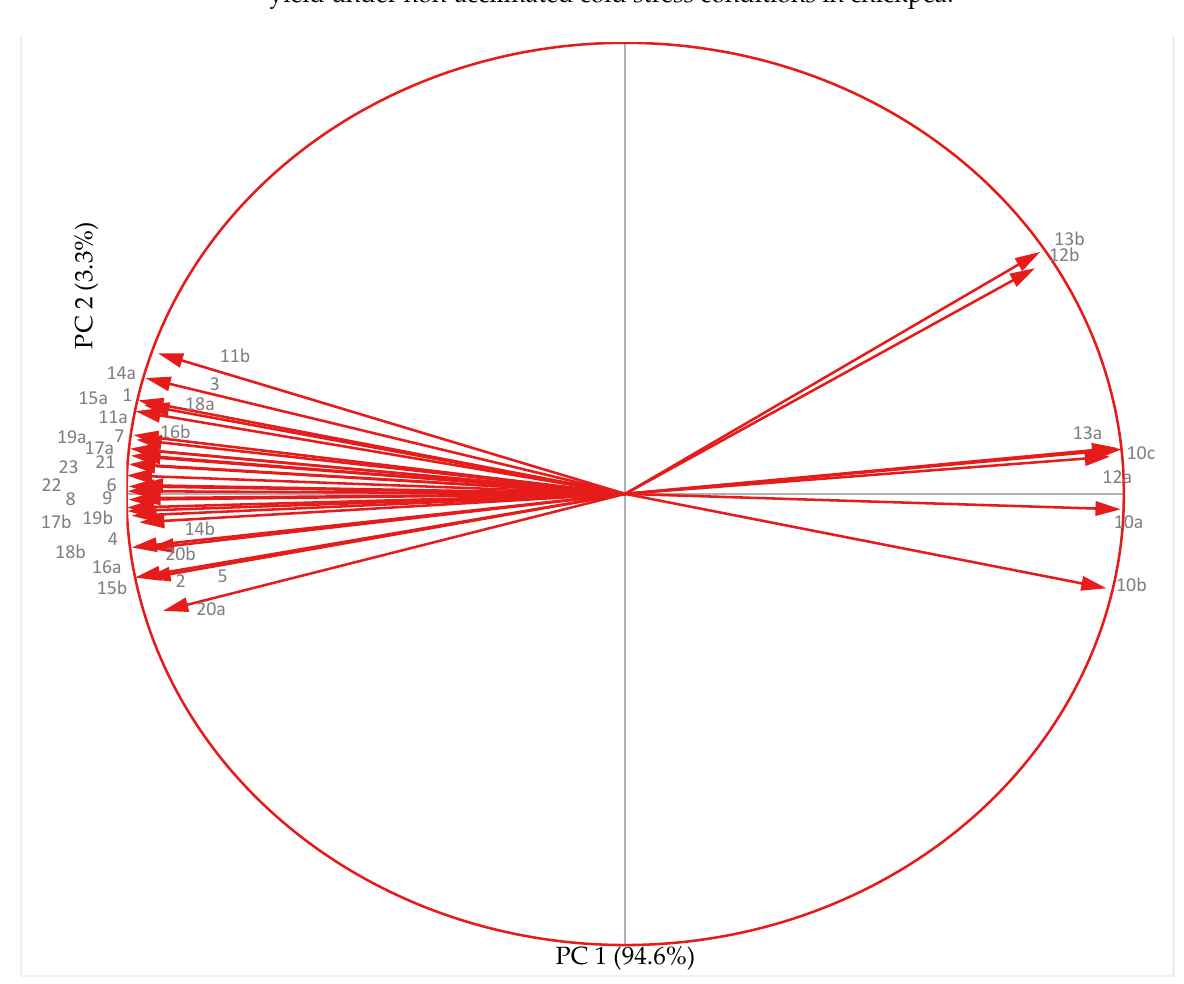
Figure 11. Principal component analysis of yield, reproductive, biochemical and leaf traits in chickpea genotypes under non acclimated conditions. Abbreviations: a-anther, b-ovule; 1-RLWC-relative leaf water content; 2-SC-stomatal conductance; 3-PSII-photosynthetic efficiency; 4-Chl-chlorophyll content; 5-CAR-carotenoids; 6-PG-pollen germination; 7-PV-pollen viability; 8-SR-stigma receptivity; 9-OV-ovule viability; 10-EL-electrolyte leakage; 11-CV-cellular viability; 12-MDA-malondialdehyde; 13-H 2 O 2 -hydrogen peroxide; 14-SOD-superoxide dismutase; 15-CAT- catalase; 16-APX-ascorbate peroxidase; 17-GR-glutathione reductase; 18-ASC-ascorbic acid; 19-GSH-glutathione; 20-proline; 21-pod set %; 22- pod number plant –1 ; 23-seed weight plant –1